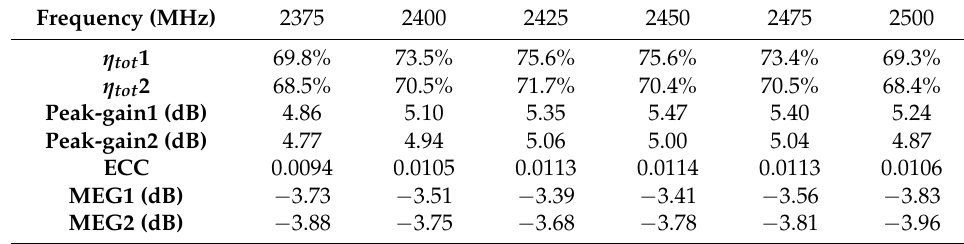
Figure 12. Measured 2 dimensional radiation patterns for Ant1 at 1570MHz. Table 1. Diversity performance of the proposed